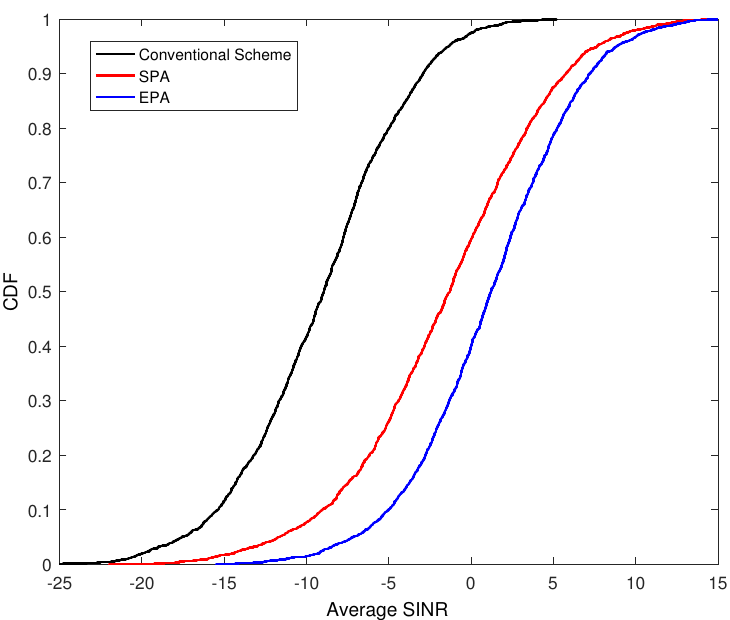
Figure 5. The cumulative distribution function (CDF) of the average signal-to-interference-plus-noise ratio (SINR) when M = 64 using ZF.